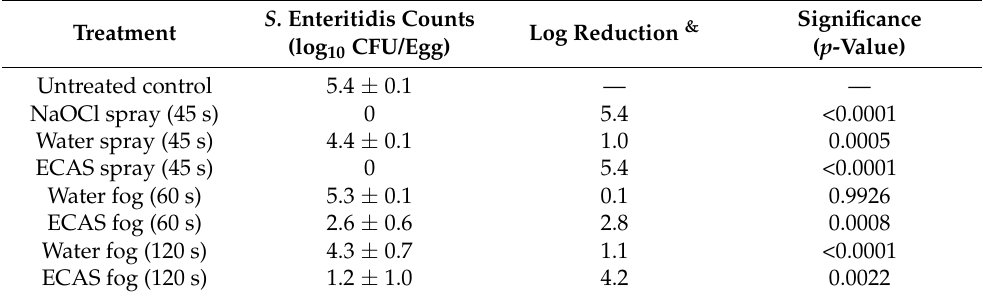
Table 2. Effect of sanitisation treatments on the reduction level of S. Enteritidis counts on egg surface.